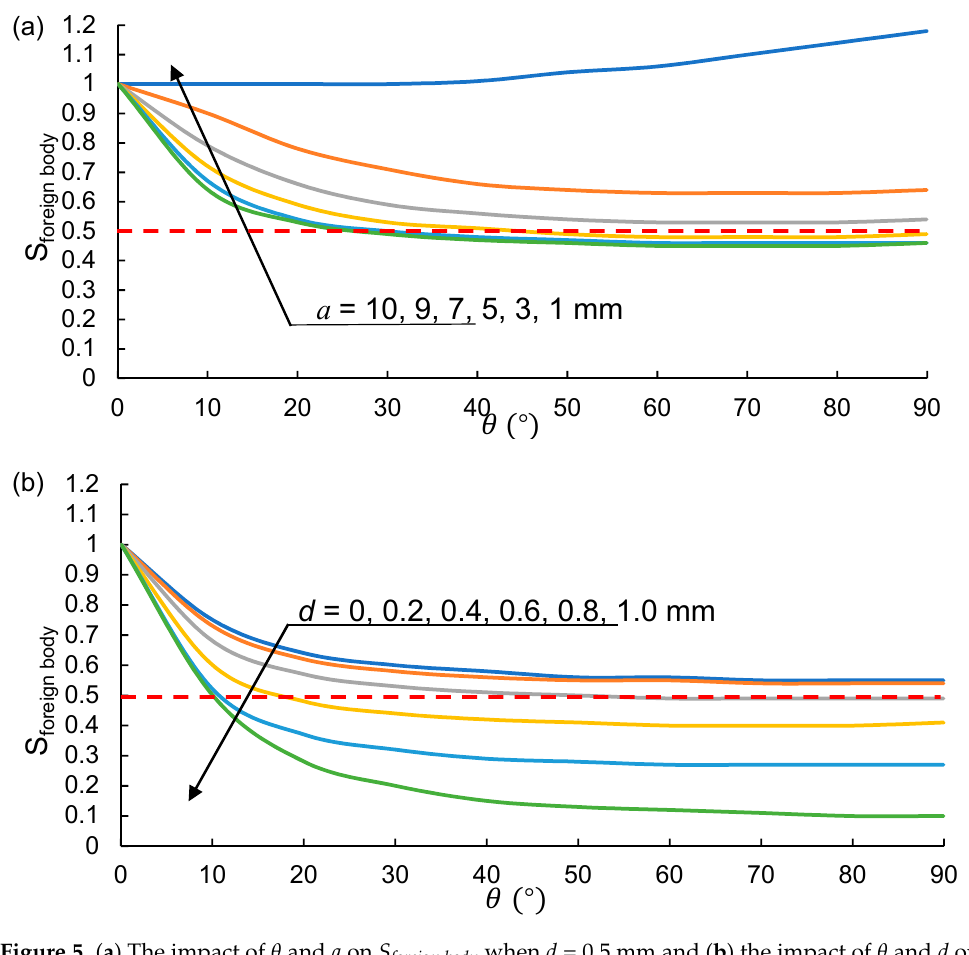
Figure 5. ( a ) The impact of θ and a on S foreign body when d = 0.5 mm and ( b ) the impact of θ and d on S foreign bod when a = 10 mm.